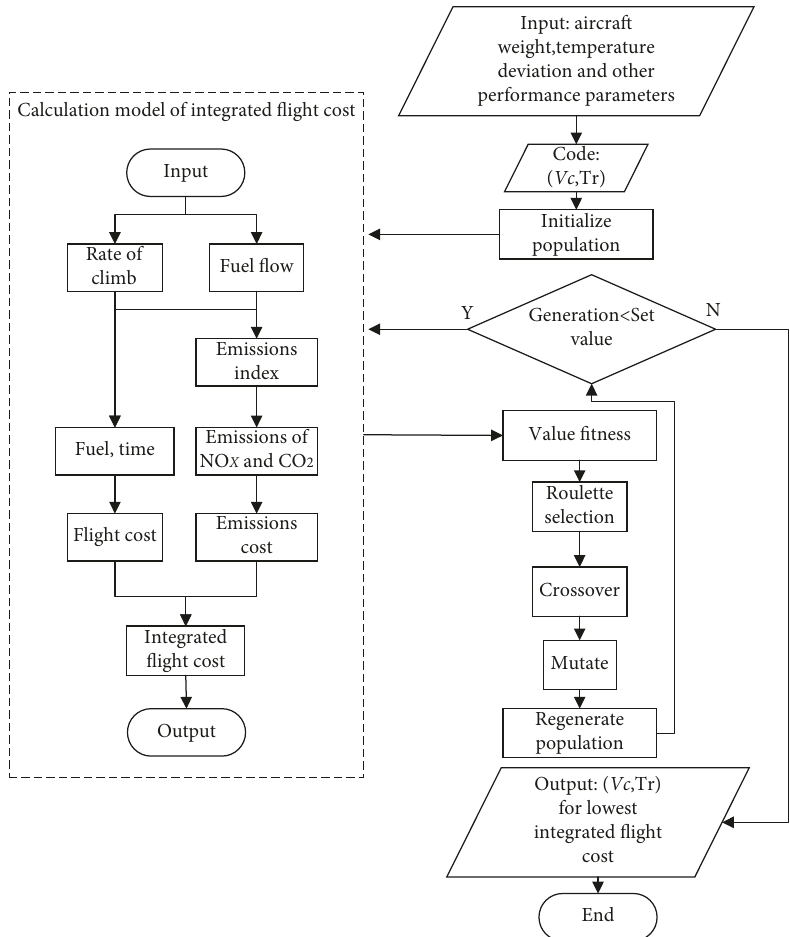
Figure 4: Flowchart of optimization calculation of comprehensive cost based on the genetic algorithm.